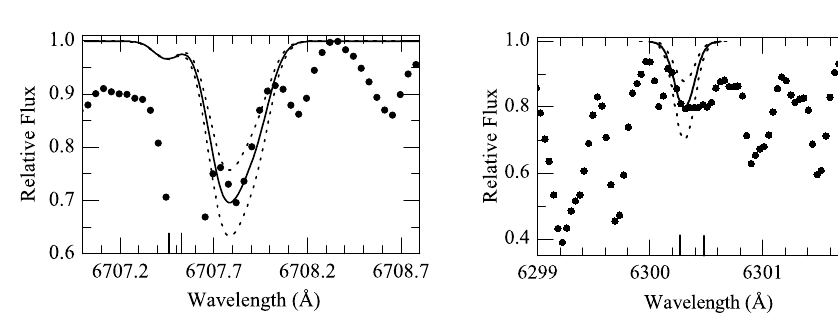
Fig. 5. The observed spectrum of HD 209621 around the lithium fea- ture. The three synthetic spectra shown are given for the lithium abundances log ϵ (Li) = 1 . 19 ± 0 . 15. The positions of close CN lines are marked by vertical ticks.